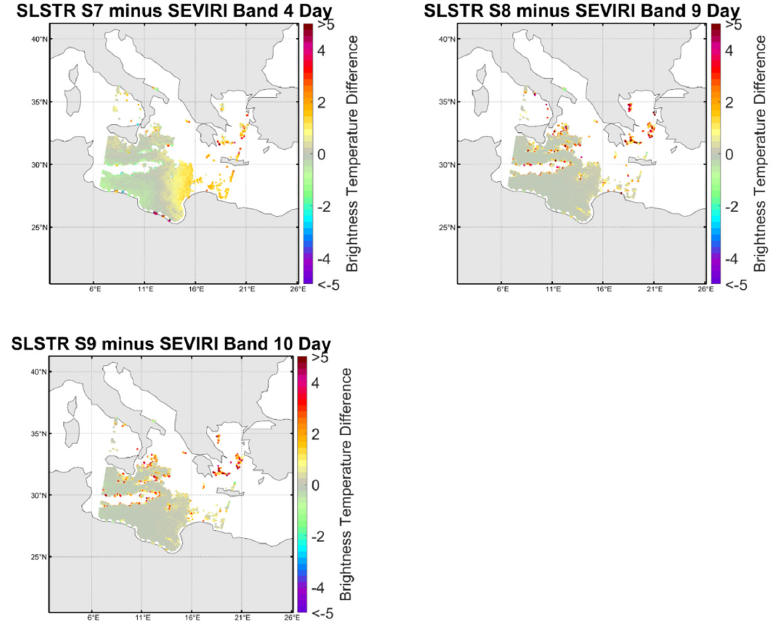
Figure 10. Distributions of the daytime BT differences between SLSTR and SEVIRI in the Mediterranean Sea region of SLSTR S7 ( top ‐ left ), S8 ( top ‐ right ) and S9 ( bottom ‐ left ). The colors indicate the SLSTR minus SEVIRI equivalent BTs.